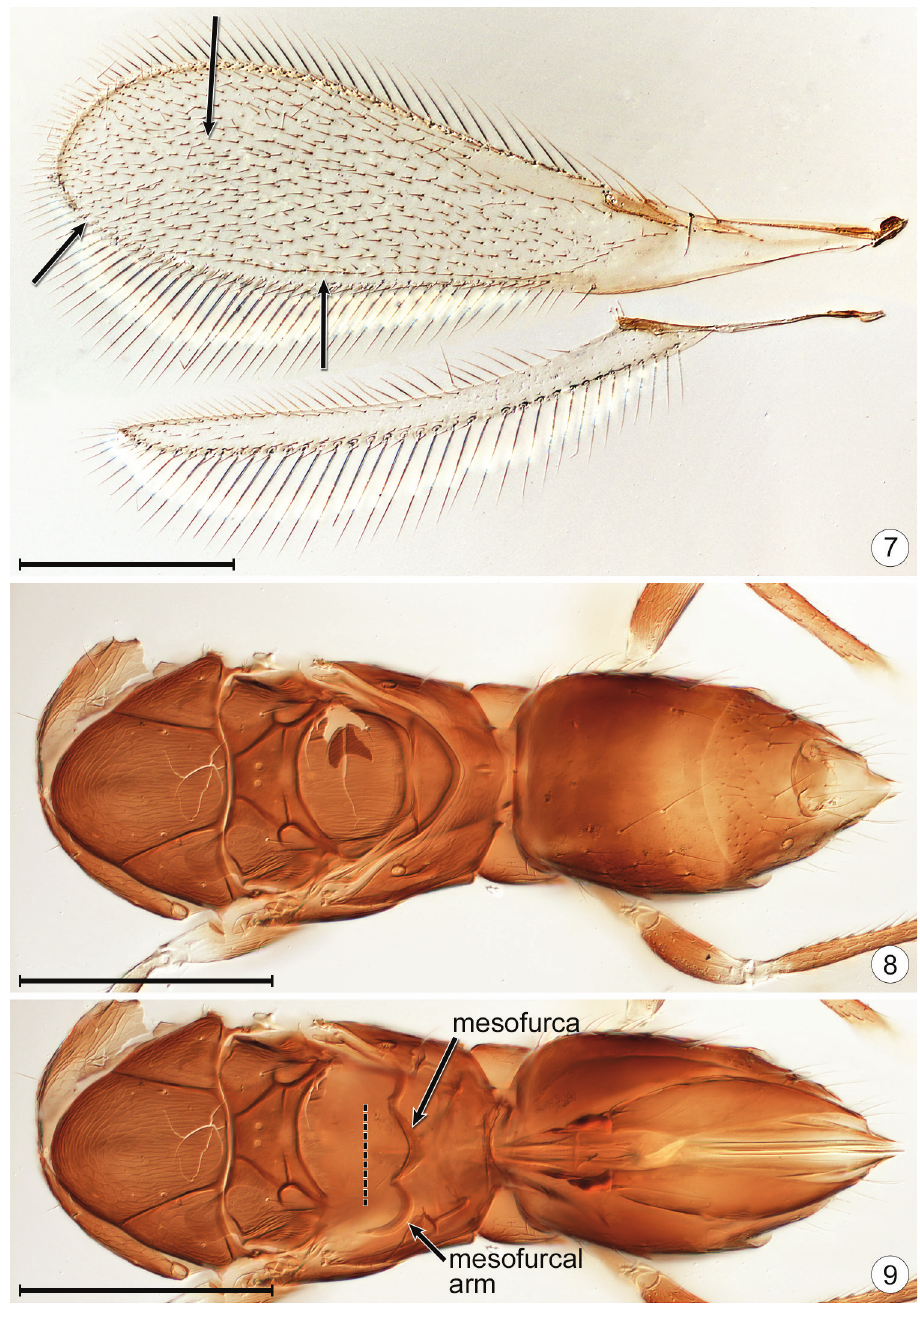
Figures 7–9. Anaphes brevis . 7 wings (see text for discussion) 8 body, dorsal 9 with frenum-gaster internal (more ventral) to show mesofurca and ovipositor through gaster; dashed line indicates anterior extension of ovipositor. Scale bars: 200